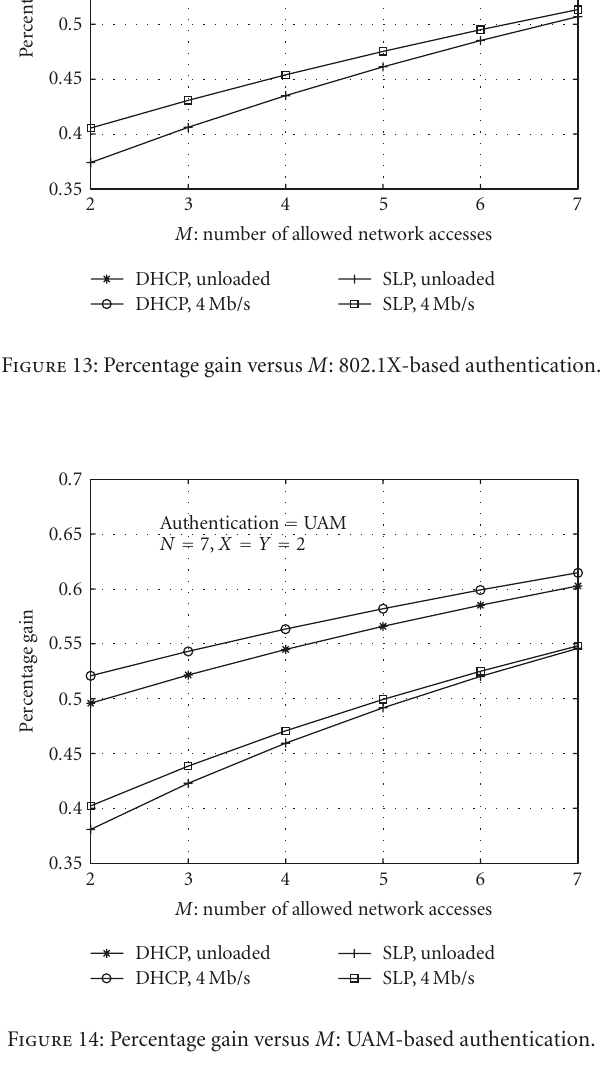
Figure 14: Percentage gain versus M : UAM-based